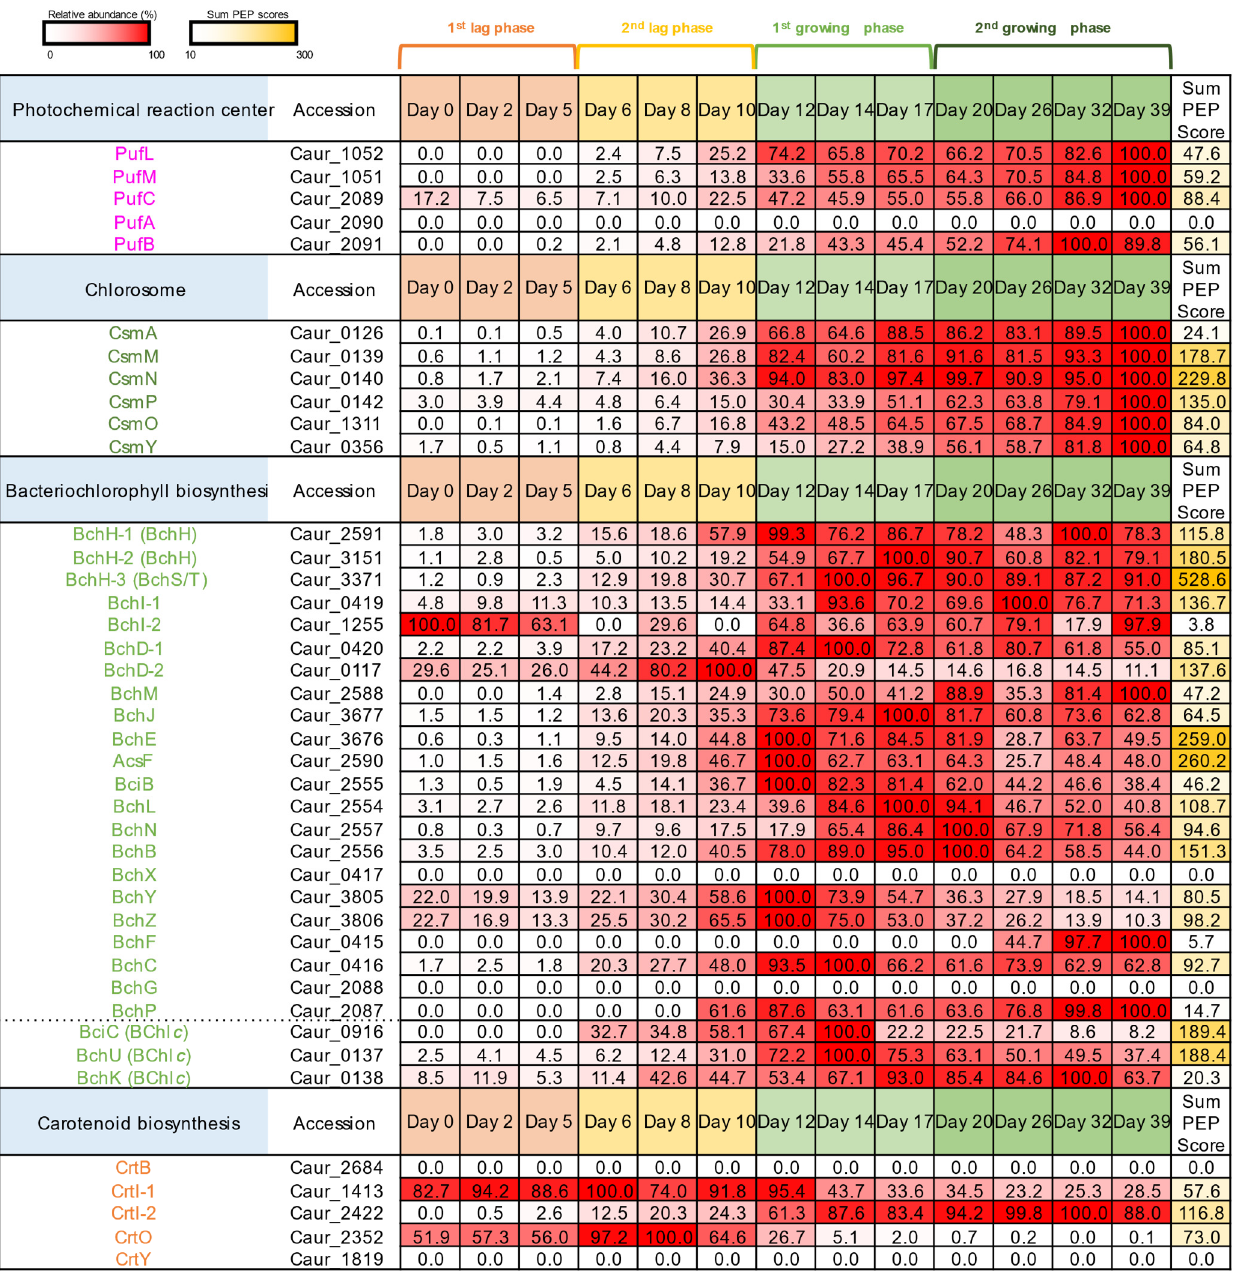
Figure 2. The relative abundance of proteins involved in reaction centers, chlorosomes, and the biosynthesis of bacteriochlorophylls and carotenoids. Relative values of protein expression among 13 sampling dates are shown as percentages indicating abundance, where “100%” indicates the highest protein expression among all sampling dates. The red color becomes deeper as the relative abundance values increase. Sum PEP scores are shown for the comparison of protein expression levels between different CDSs. The yellow color becomes deeper as the Sum PEP scores increase.